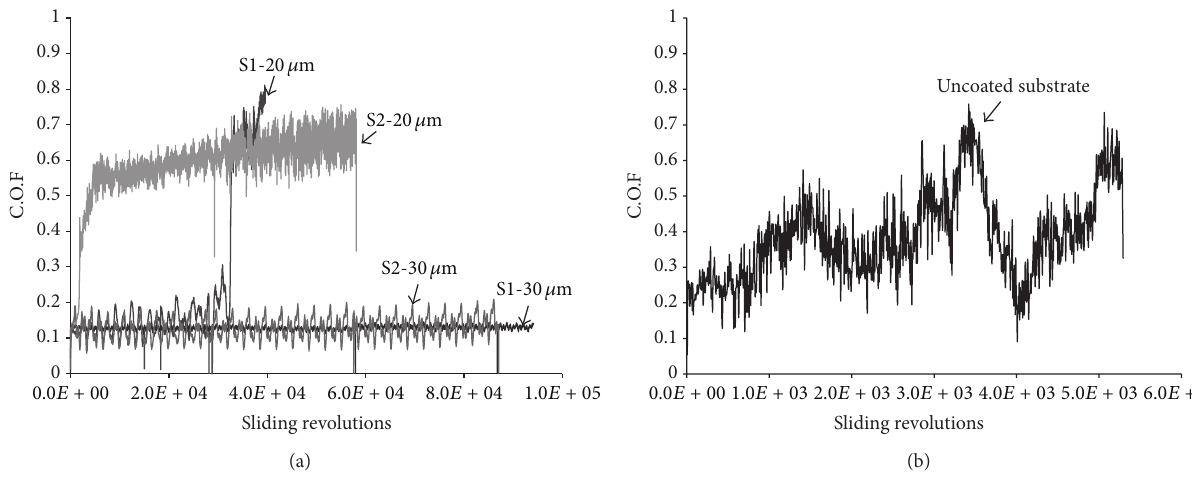
Figure 6: Coefficient of friction (C.O.F.) versus sliding distance ( 𝑚 ) on (a) both sides of S1 and S2 and (b) the uncoated